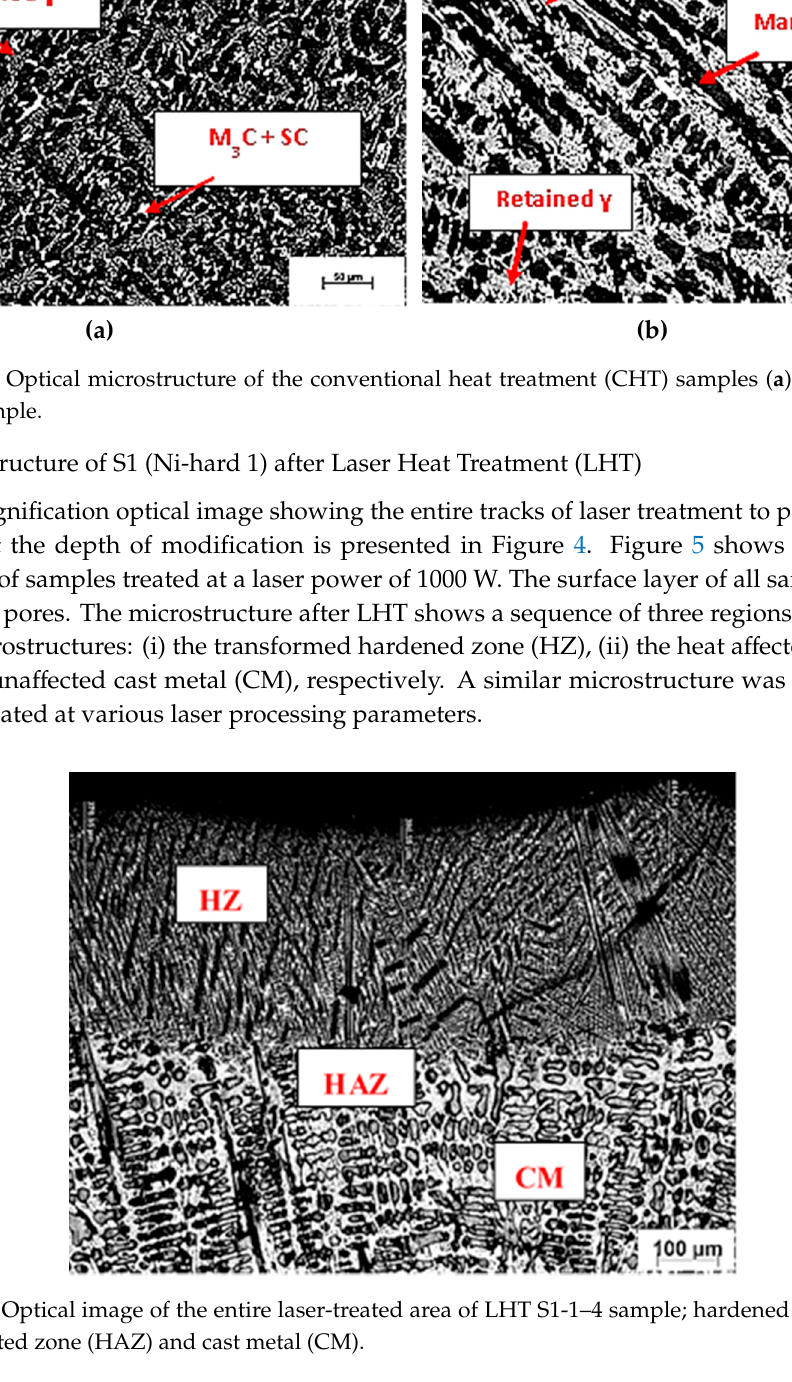
Figure 2. Optical microstructure of the as-cast ( a ) S1 (Ni-hard 1) sample ( b ) S2 (Ni-hard 4) sample.